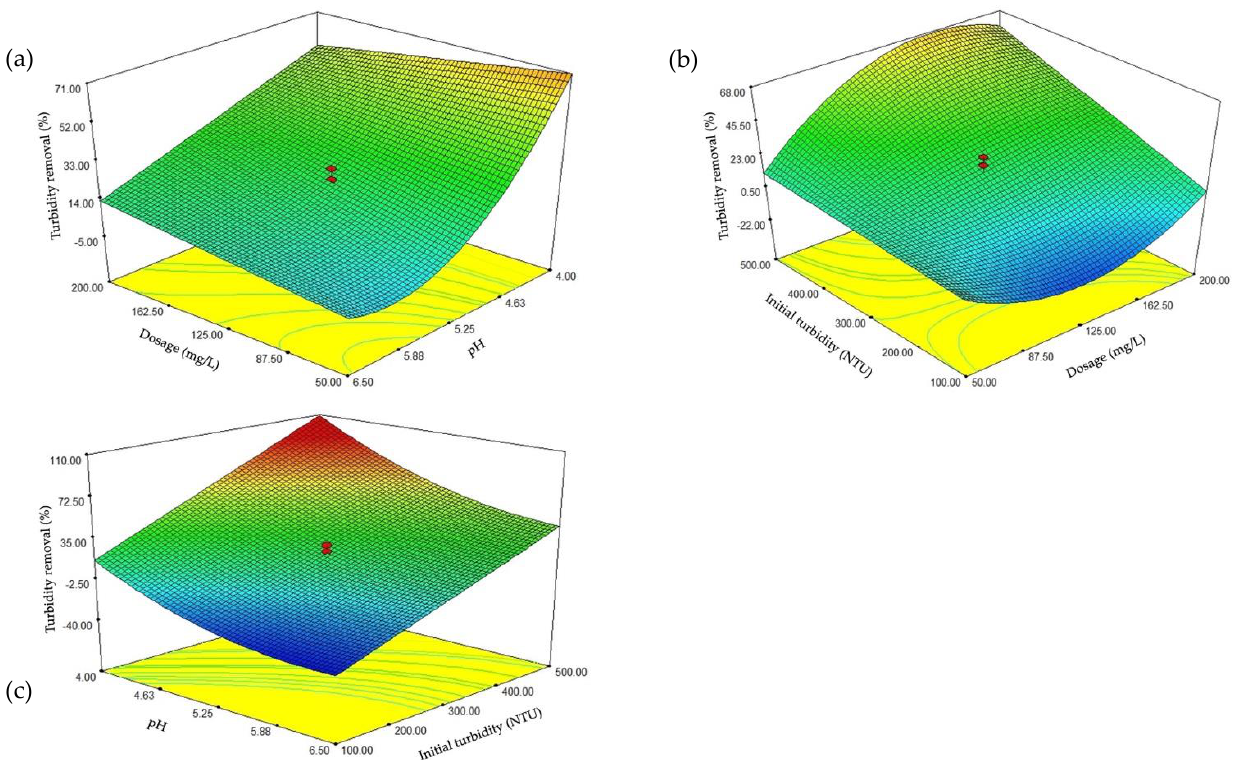
Figure 4. Response surface of the turbidity removal as a function of ( a ) deshelled Carica papaya seeds dosage and pH, ( b ) deshelled Carica papaya seeds dosage and initial turbidity and ( c ) pH and initial turbidity.